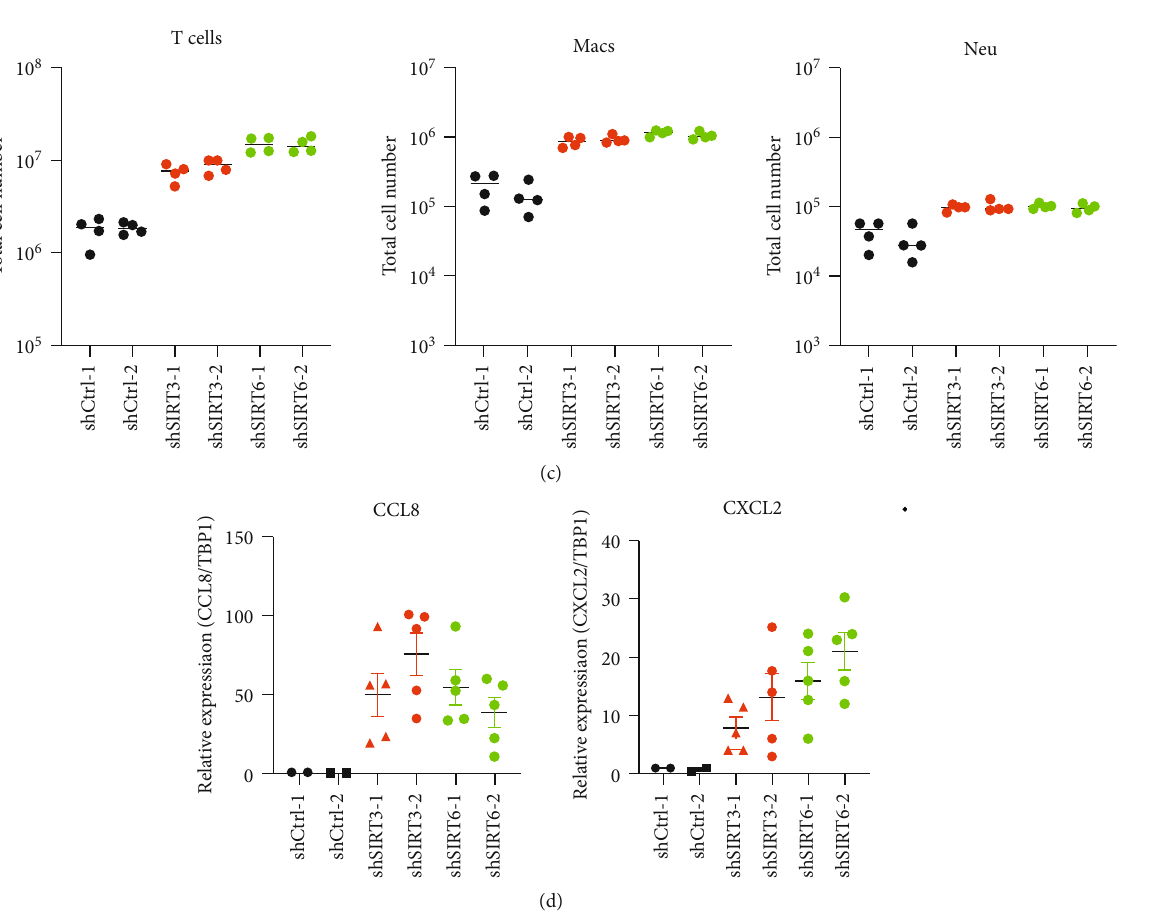
Figure 4: Necroptosis-induced innate immune cell recruitment controlled by both SIRT3 and SIRT6 is required to suppress prostate cancer progress. (a) Growth curves of xenografted tumors (LNCaP) after induction of control, SIRT3, or SIRT6 shRNA expression with doxycycline in vivo. Relative tumor volumes were calculated by normalizing against the tumor volume at day 1 following doxycycline administration. Body weight was tested daily. (b) Representative experiment of fl ow cytometric analysis of T cells, macrophages, and neutrophils in doxycycline-induced xenografted tumors (LNCaP). (c) The total number of T cells, macrophages, and neutrophils was showed in the histograms. Results represent mean ± SD of three independent experiments. ∗ P < 0 : 05 . (d) The relative expression of CCL8 and CXCL2 is shown in the histograms. GAPDH was used as the internal control. Results represent mean ± SD of three independent experiments. ∗ P < 0 : 05 and ∗∗ P < 0 : 01